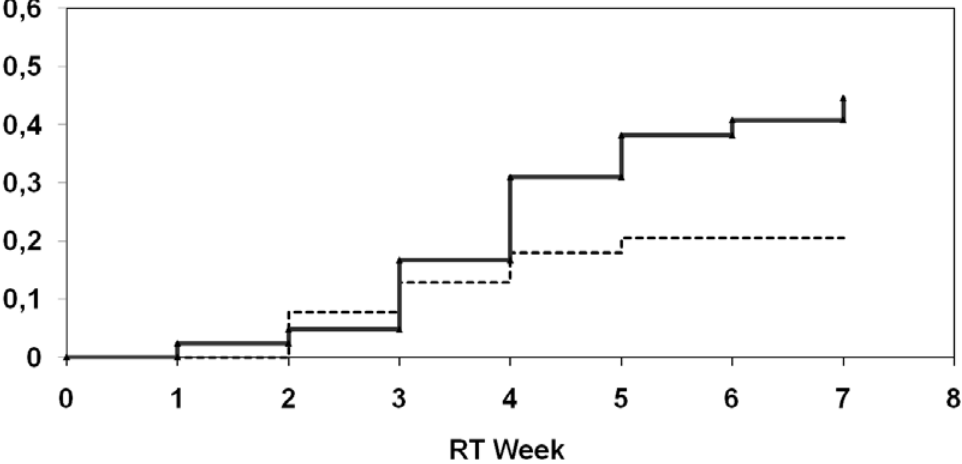
Figure 2. Univariate analysis (log-rank) for the incidence of at least diarrhea CTC 2 depending on supplementation of selenium (upper curve: without selenium; lower curve: with selenium).